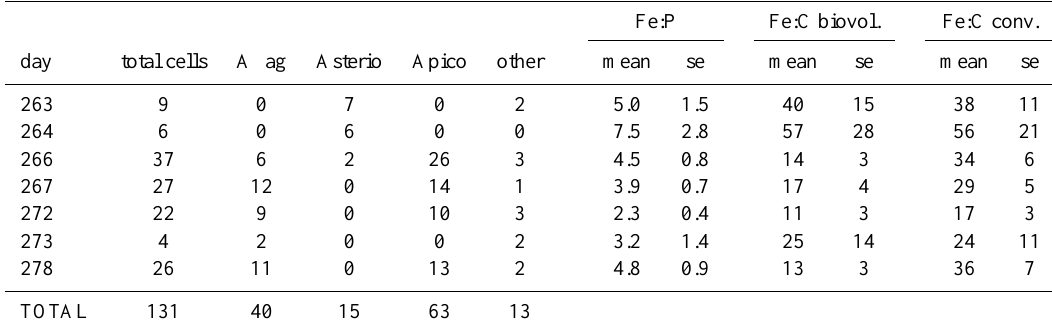
Table 4. Number of cells analyzed by SXRF by date and cell type (Aflag=autotrophic flagellates, Asterio= Asterionellopsis glacialis , Apico=autotrophic picoplankton, other=other diatoms) and LS mean Fe:P (mmol:mol), LS mean Fe:C biovol (µmol:mol; C calculated using biovolume estimates), and LS mean Fe:C (µmol:mol; C converted using 133molC:molP) ( ± standard error; se) calculated for each year day. Fe:P Fe:C biovol. Fe:C conv.